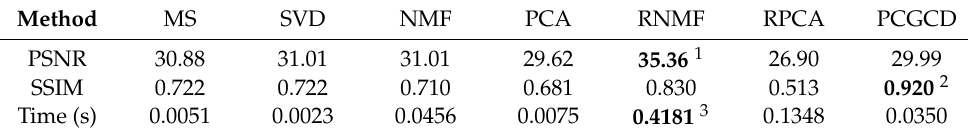
Figure 8. Clutter suppression results for a hybrid raw GPR image with different methods. Table 7. Running time evaluation of different clutter removal methods in simulate GPR